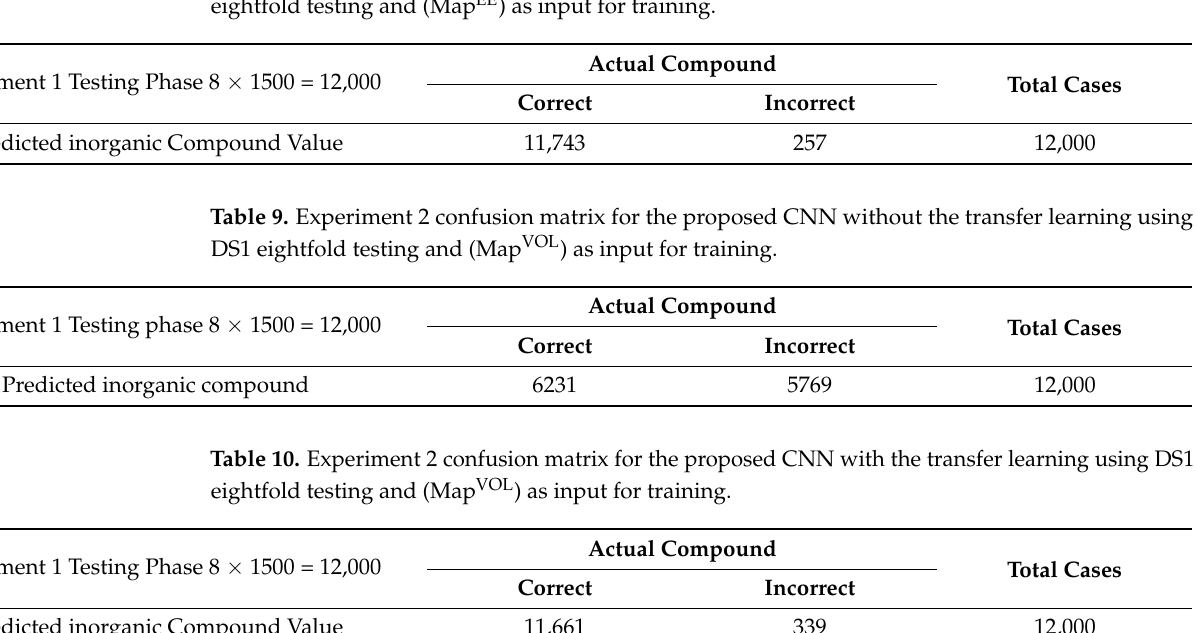
Table 8. Experiment 1 confusion matrix for the proposed CNN with the transfer learning using DS1 eightfold testing and (Map EE ) as input for training.